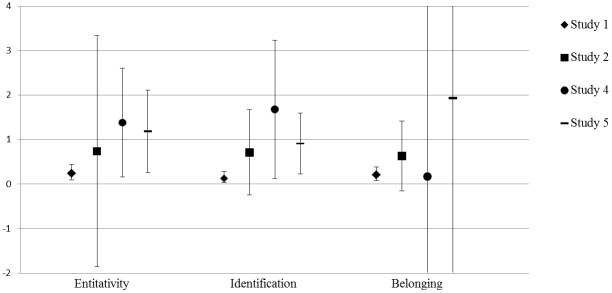
95% confidence intervals of the indirect effects of Contrast 2 (complementarity vs. synchrony) via personal value to the group on the different indicators of solidarity in Study 1, 2, 4, and 5.